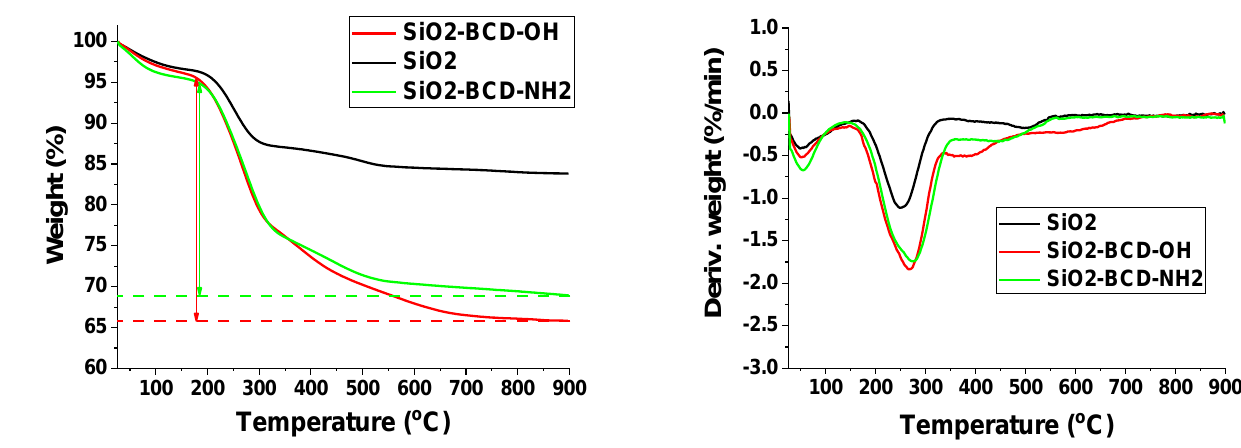
Figure 2. TGA and DTG analyses of the synthesized silica-BCD materials. To more accurately determine the amount of BCD attached to the silica, UV-Vis anal- ysis was employed. Thus, the determined BCD content was 23.97% (weight %) and 23.49 (weight %) for SiO 2 -BCD-OH and SiO 2 -BCD-NH 2 , respectively. Thus, the degree of mod- ification of the silica with BCD was almost identical, which can be explained by the high reactivity of the -NCO towards -NH 2 and -OH. The morphological investigation of the materials was performed by scanning elec- tron microscopy (Figure 3).